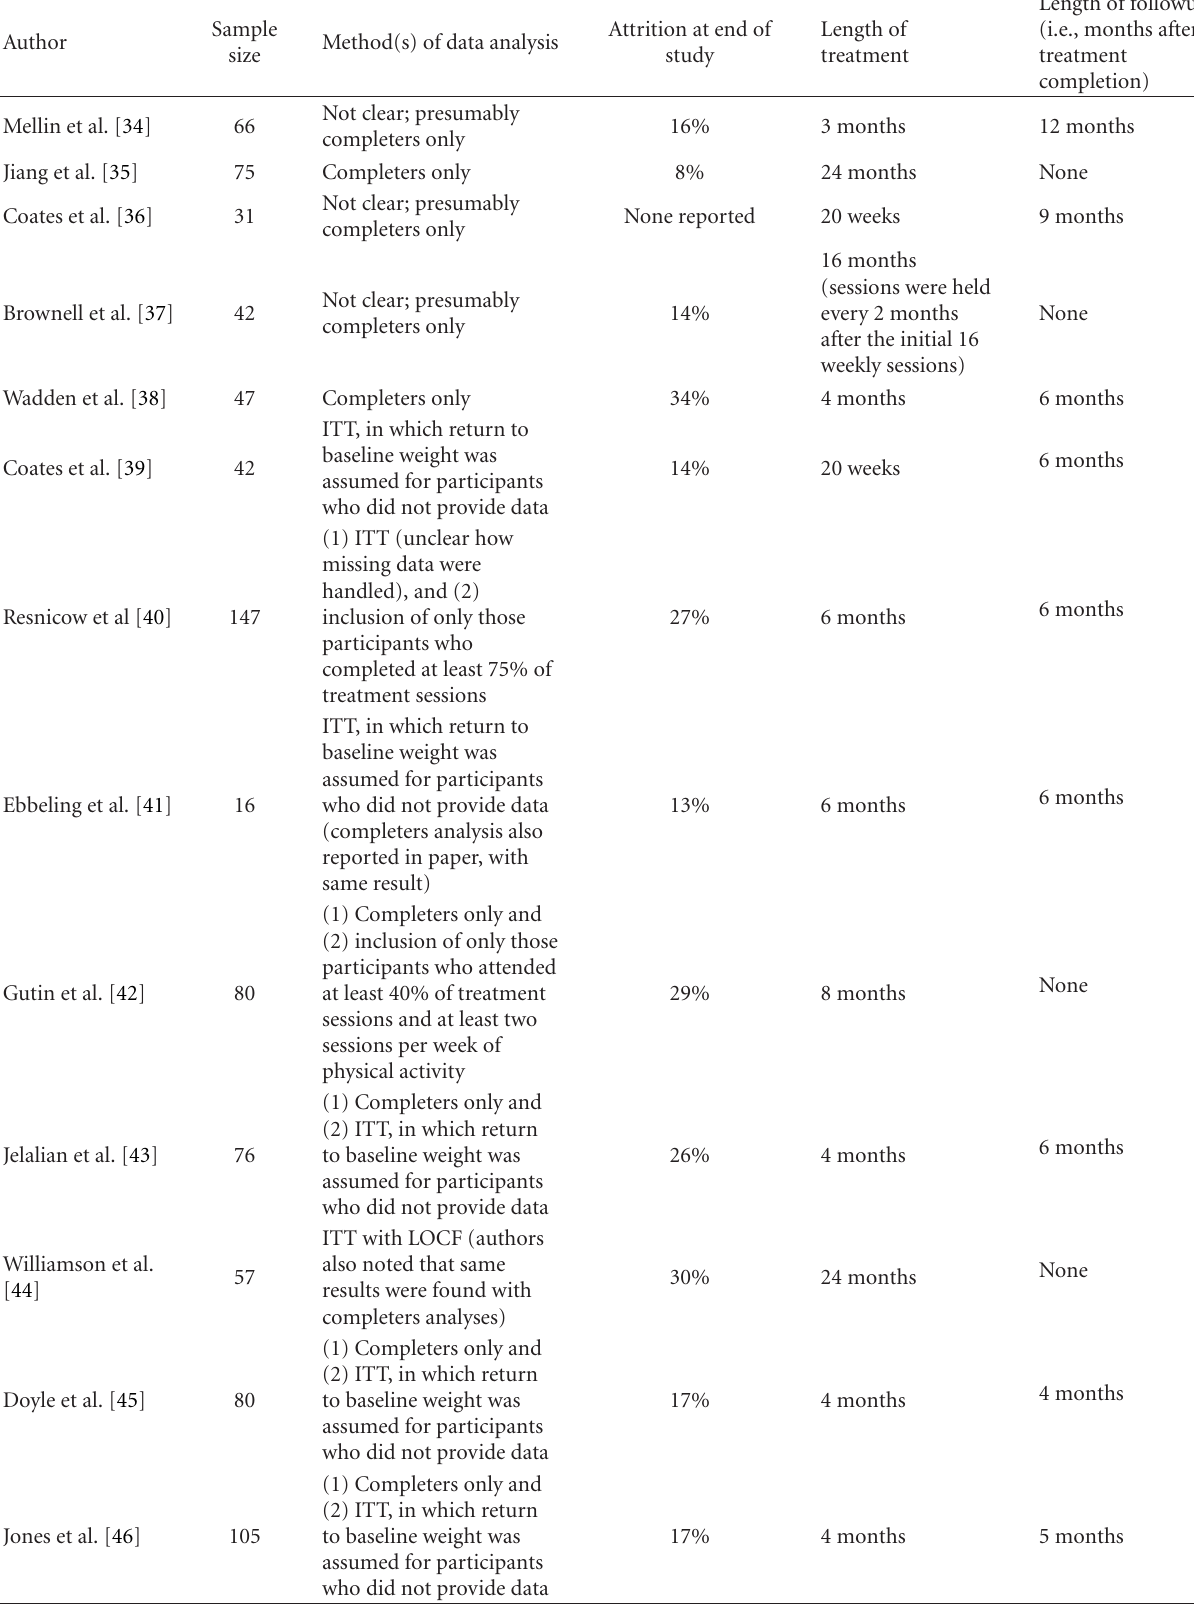
Table 1: Characteristics of Adolescent Clinical